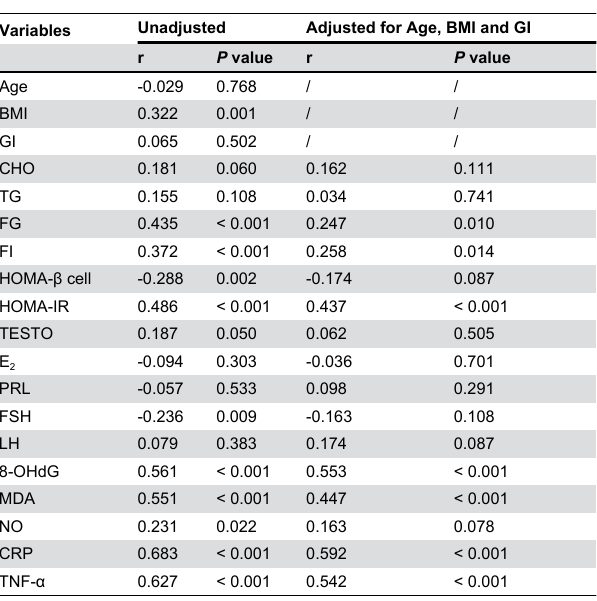
correlation coefficients were calculated between Hsp70 and other variables.